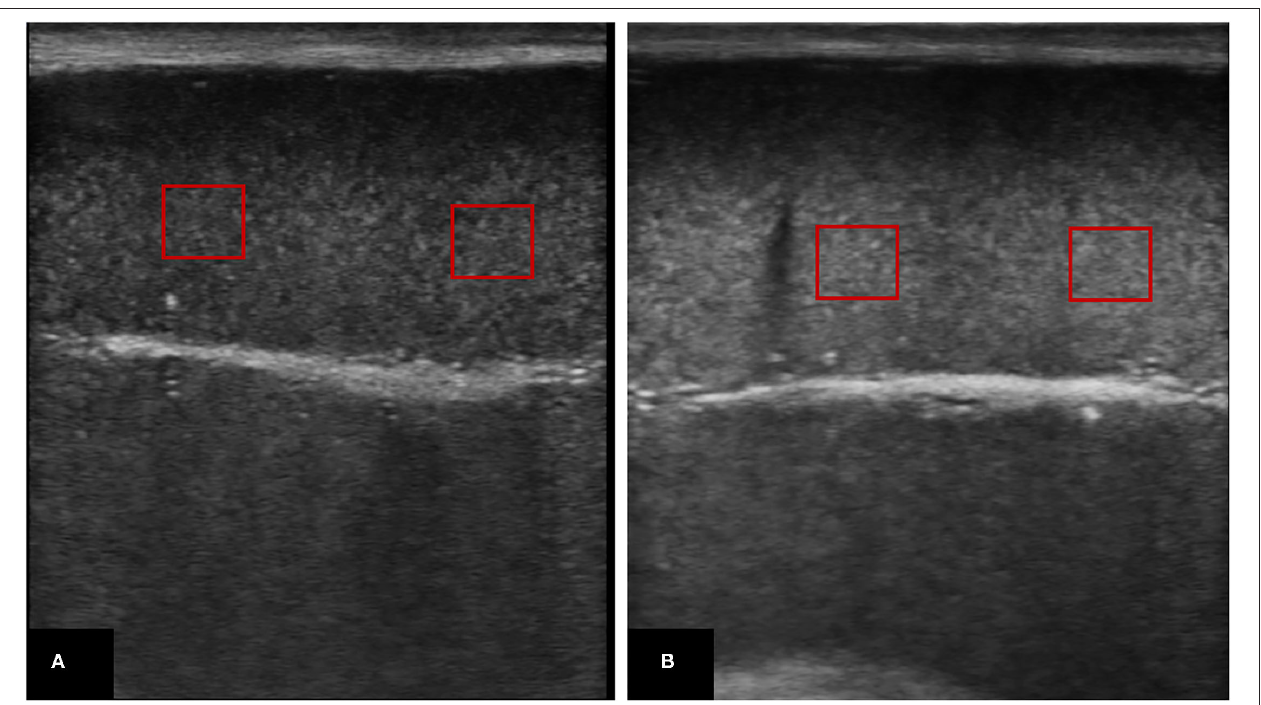
FIGURE 2 | Ultrasonograms of the testicular parenchyma in which echotextures were assessed by placing at least 3 squares (1cm × 1cm) and underwent computed digital analysis (Adobe Photoshop 64 CC software); (A) represents testicular parenchyma with low echotexture, whereas (B) represents higher